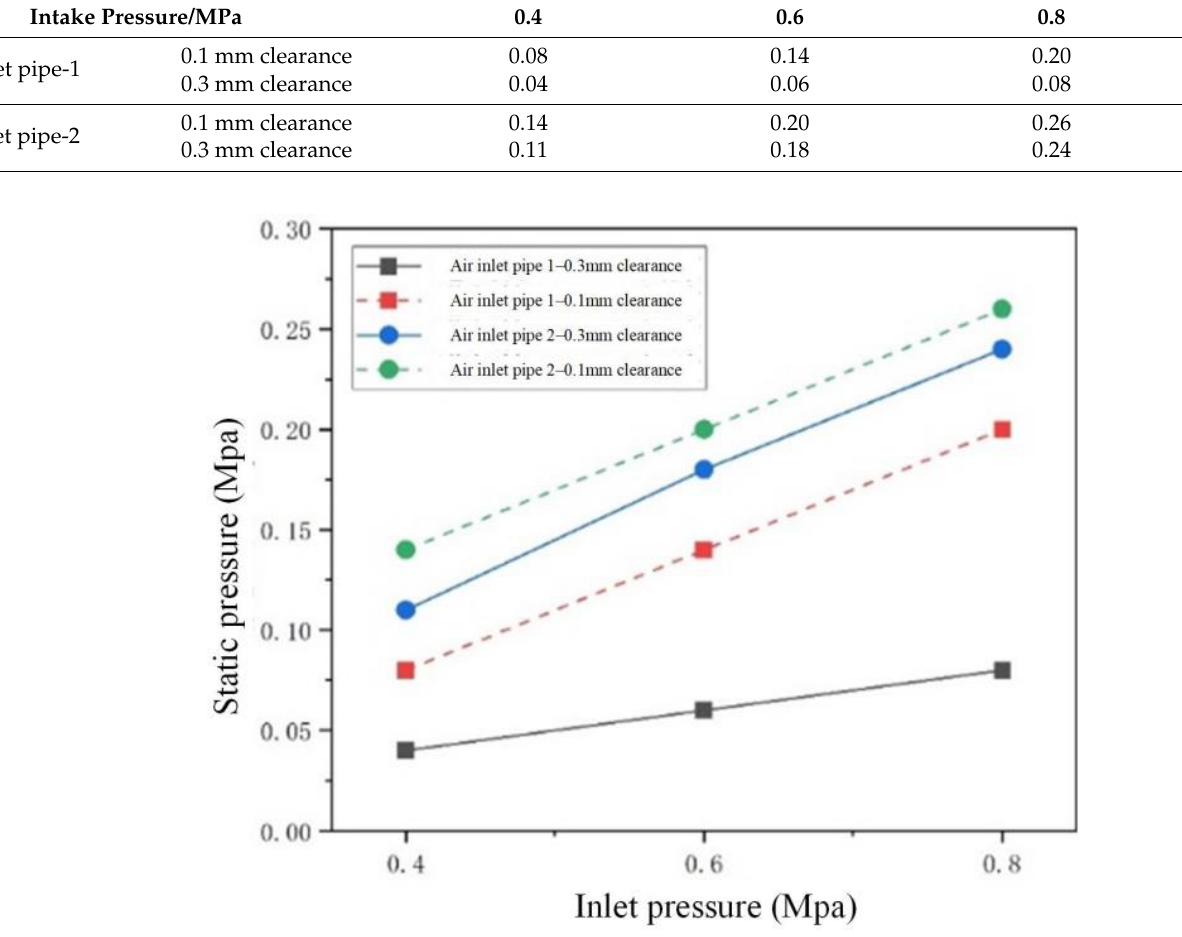
Figure 18. Measured static pressure.